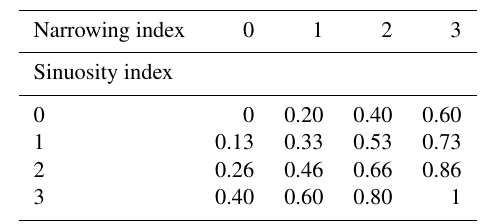
Table 3. Possible results from the ice jam predisposition index (IJPI). Values ≥ 0.40 were selected as representing a moderate pre- disposition to ice jams while values ≥ 0.54 would represent a strong predisposition to ice